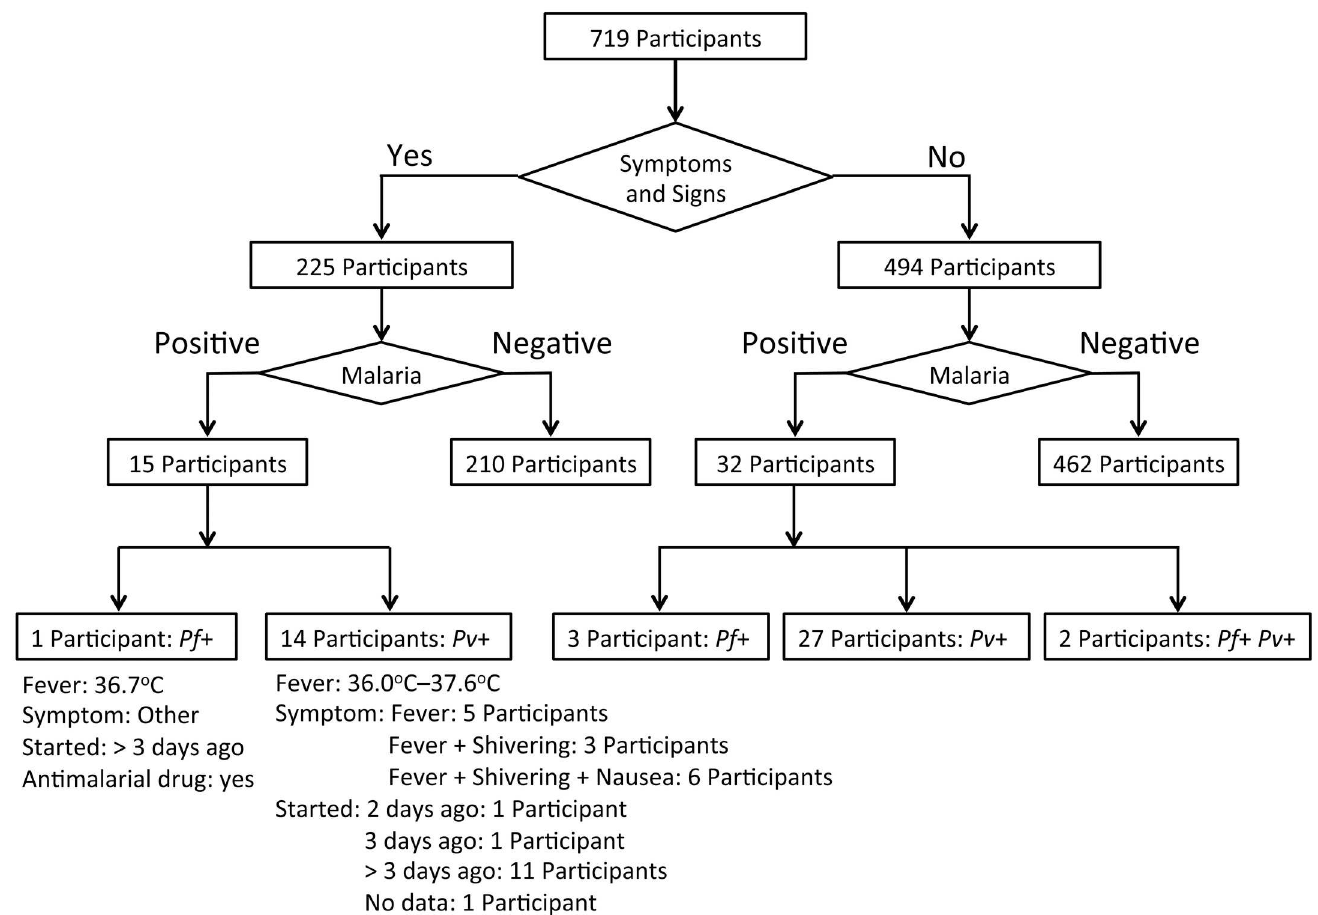
Fig 2. Flowchart summaryof malaria screening based on the clinical and PCR